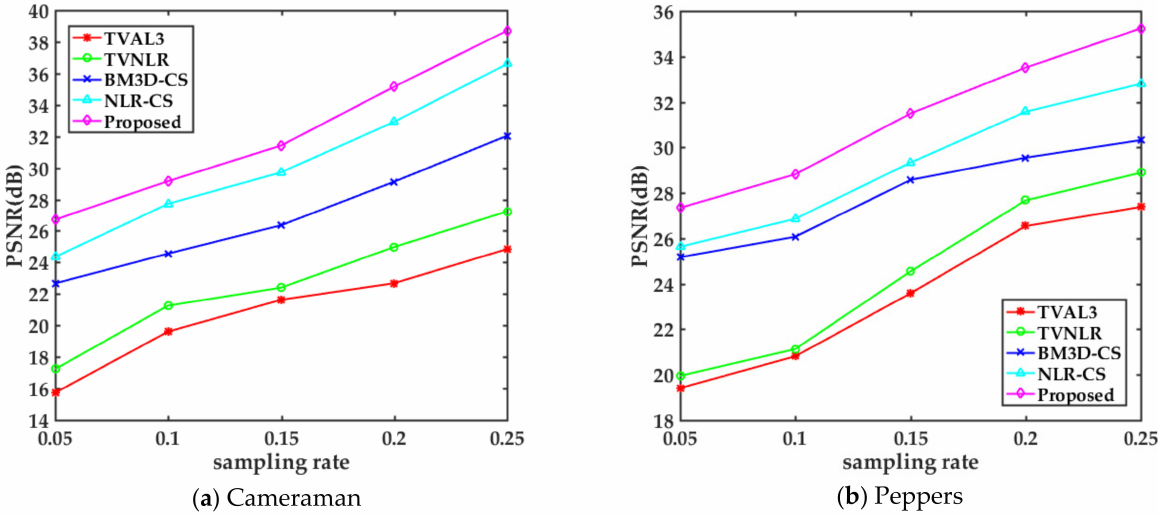
Figure 4. The PSNR (dB) curves of the ( a ) Cameraman and ( b ) Peppers images reconstructed at different sampling rates reconstructed by different